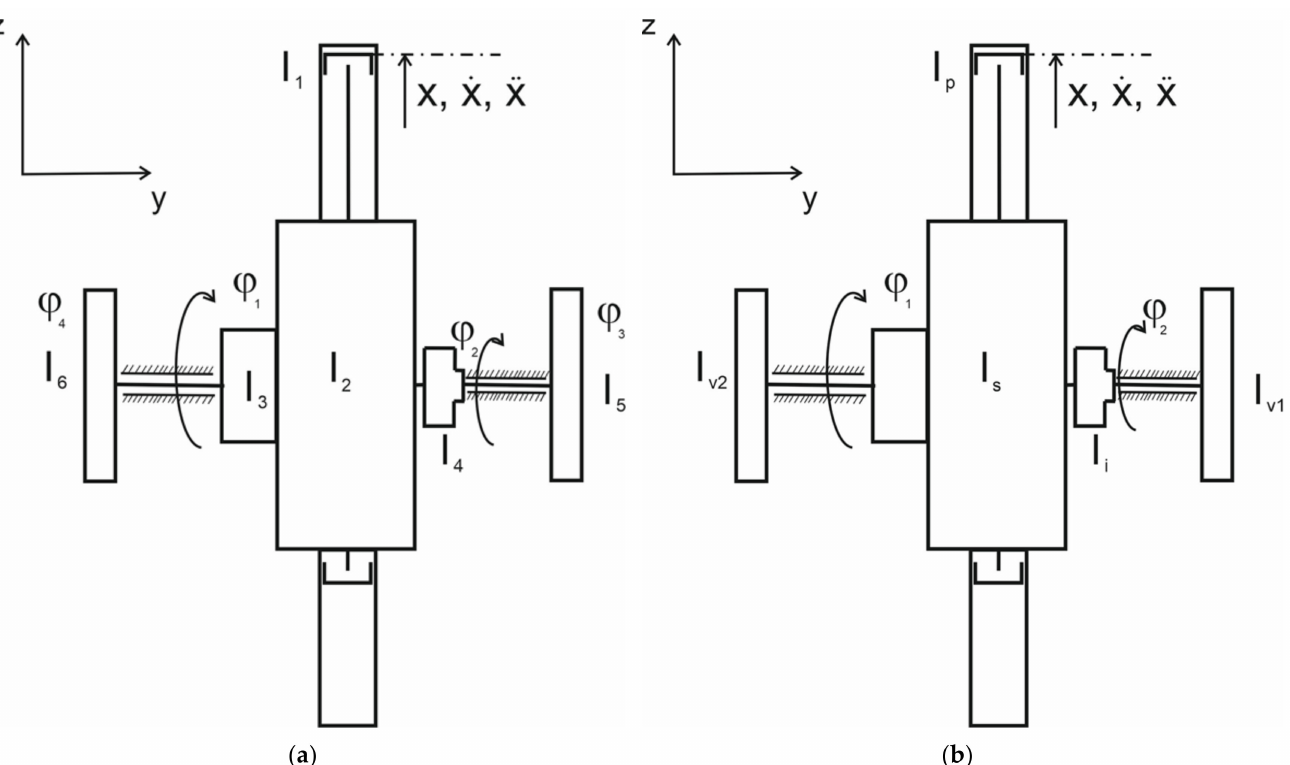
Figure 7. The calculation scheme of the mechanism: ( a ) a plane scheme of the designed mechanism with all components depicted; ( b ) a plane scheme of the designed mechanism with the components reduced to rotating